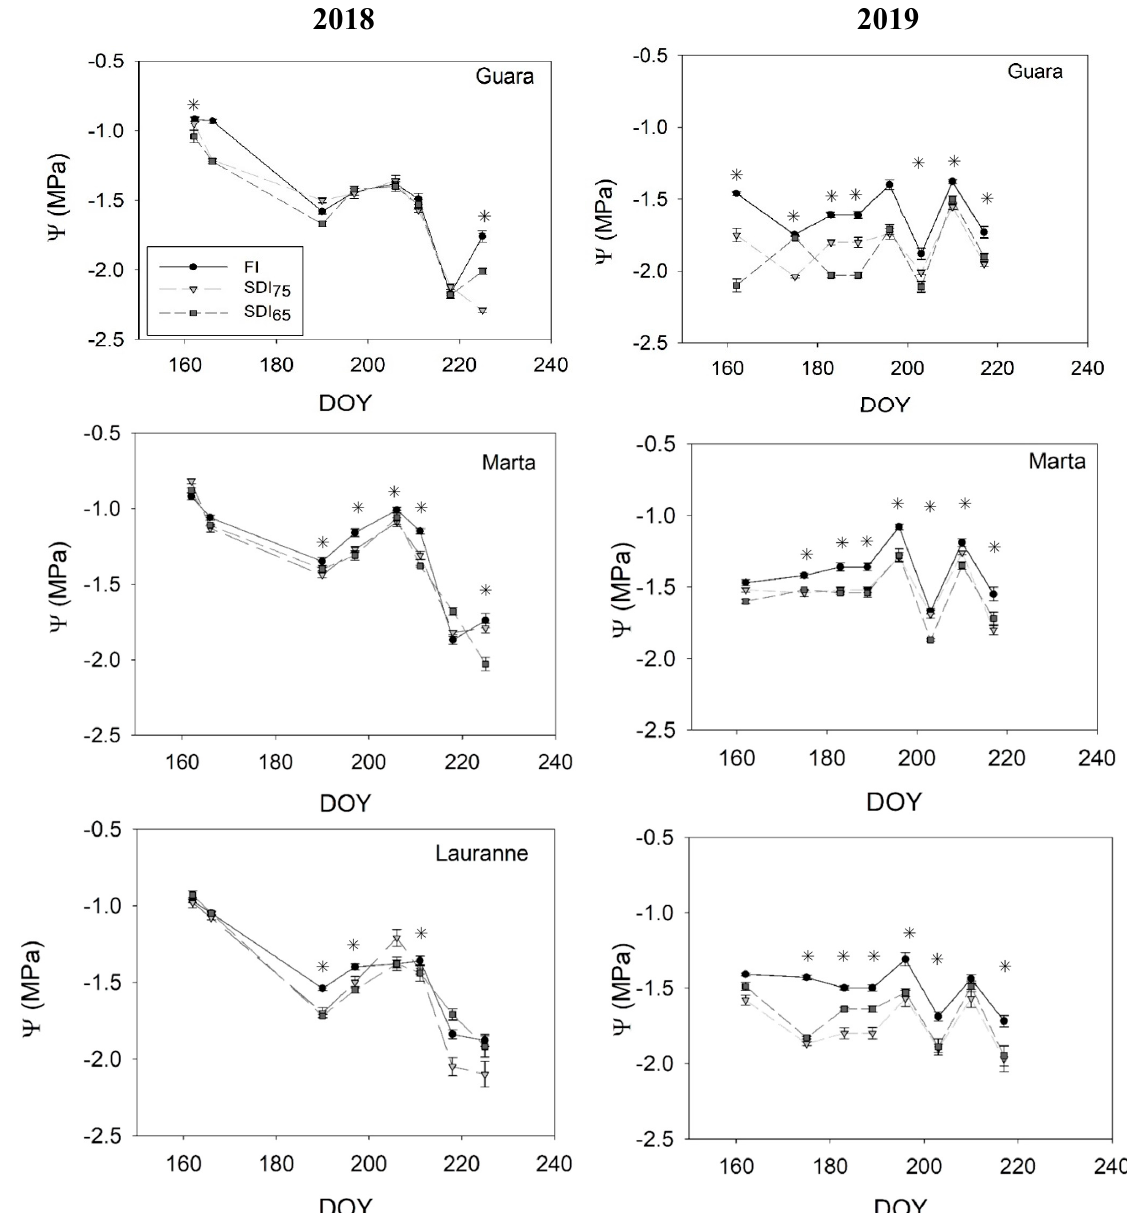
Figure 2. Seasonal dynamics of leaf water potential ( Ψ leaf ) during 2018 and 2019. FI, Full irrigated treatment; SDI 75 , sustained-deficit irrigation at 75% IR; SDI 65 , sustained-deficit irrigation at 65% IR, DOY; Day of the year. Vertical bars are standard deviation. Asterisks show the intervals with significant differences between FI and SDI treatments ( p < 0.05 ).